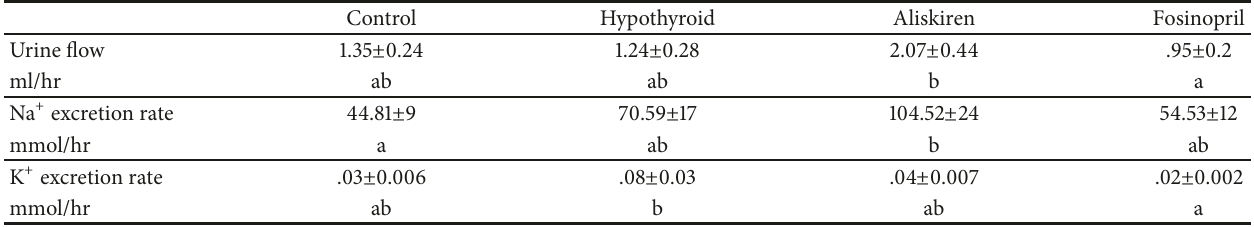
Table 9: Urine flow, Na + excretion rate, and K + excretion rate in hypothyroidism, Aliskiren, and Fosinopril.